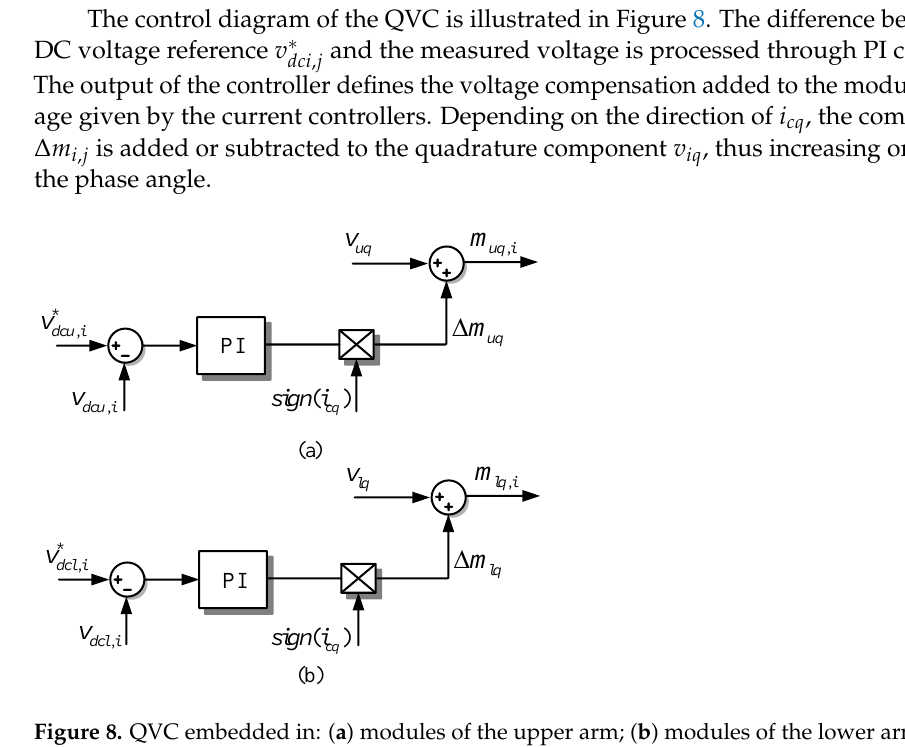
Figure 8. QVC embedded in: ( a ) modules of the upper arm; ( b ) modules of the lower arm.